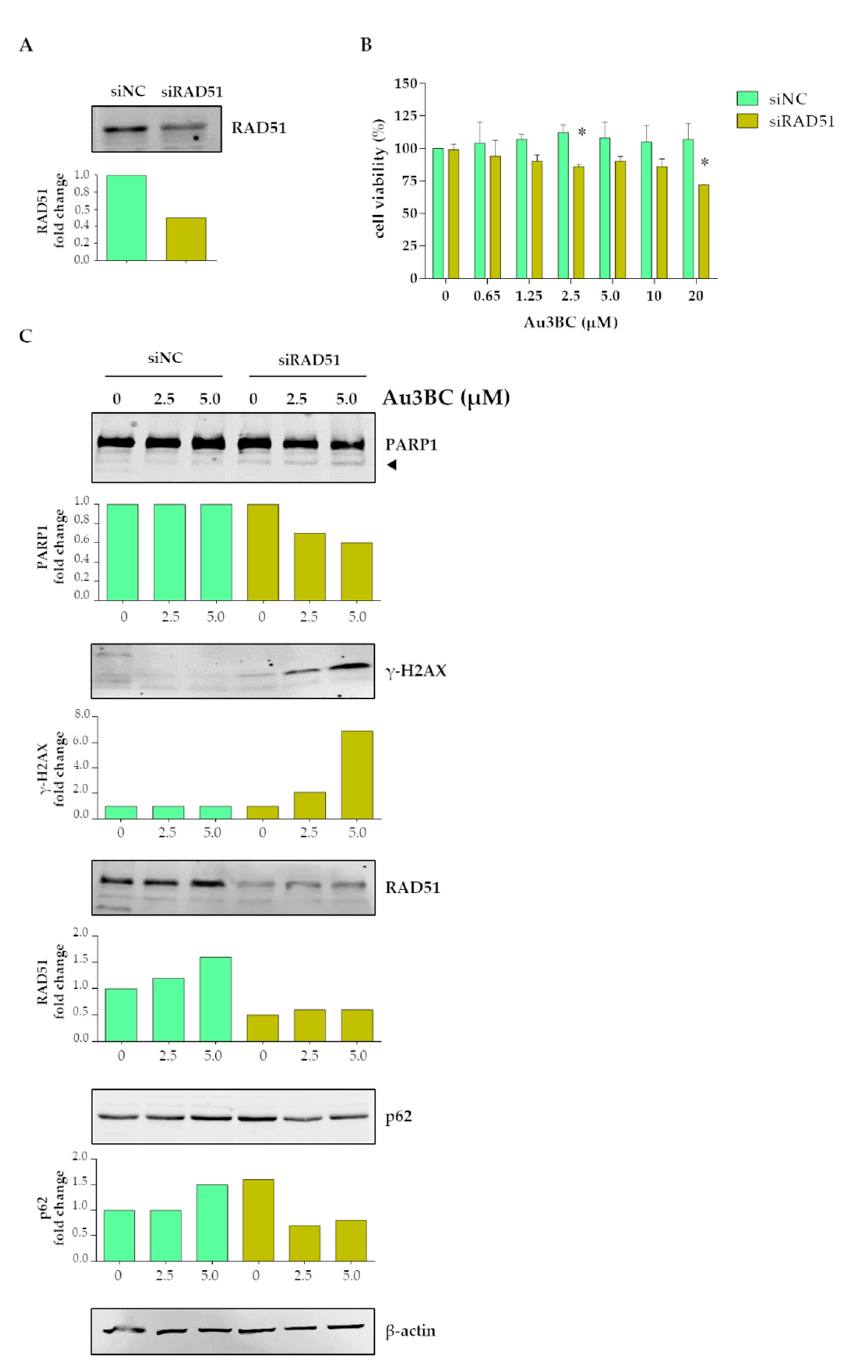
Figure 7. RAD51 knockdown sensitizes Huh7 cells to Au3BC-mediated cell death. ( A ) RAD51 expression levels in cells transfected for 72 h with RAD51 siRNA (siRAD51) or with control siRNA (siNC). ( B ) Cell viability after treatment with the indicated Au3BC concentrations for 72 h of cells transfected with siRAD51 or siNC. * p < 0.05. ( C ) Representative Western blotting of PARP1, γ -H2AX, RAD51, and p62 levels expressed in Huh7 cells transfected with siRAD51 or siNC. The PARP1 fragment (85 kDa) is indicated by an arrowhead. The numbers in the bar plots represent the ratio of the relevant protein normalized with β -actin, with vehicle-treated control samples arbitrarily set at 1.0.